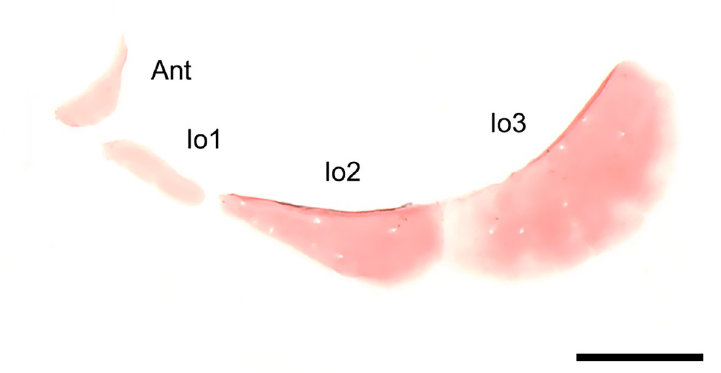
Fig 9. Circumorbital bones of Tyttobrycon shibattai . MZUSP 125269, paratype, 14.6 mm SL. Antorbital (Ant) and infraorbital (Io). Scale bar 0.5 mm.